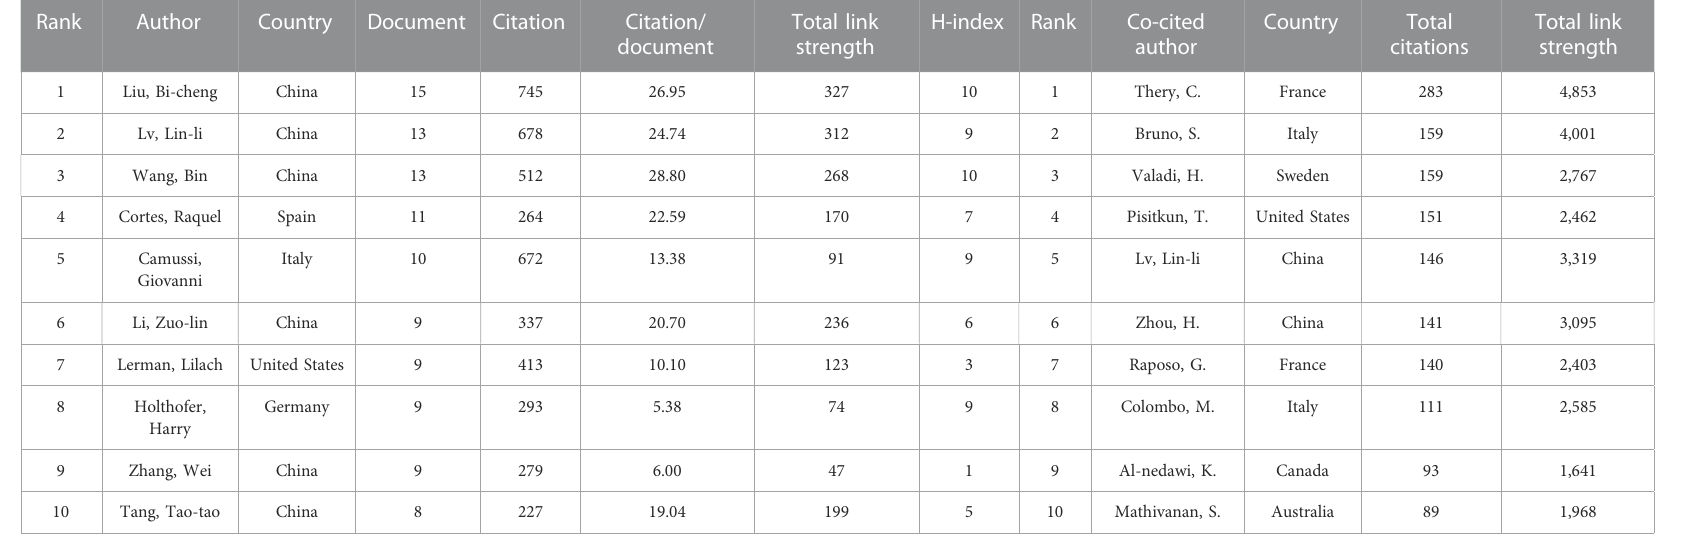
TABLE 3 Top 10 authors and co-cited authors in the fi eld of extracellular vesicle in kidney